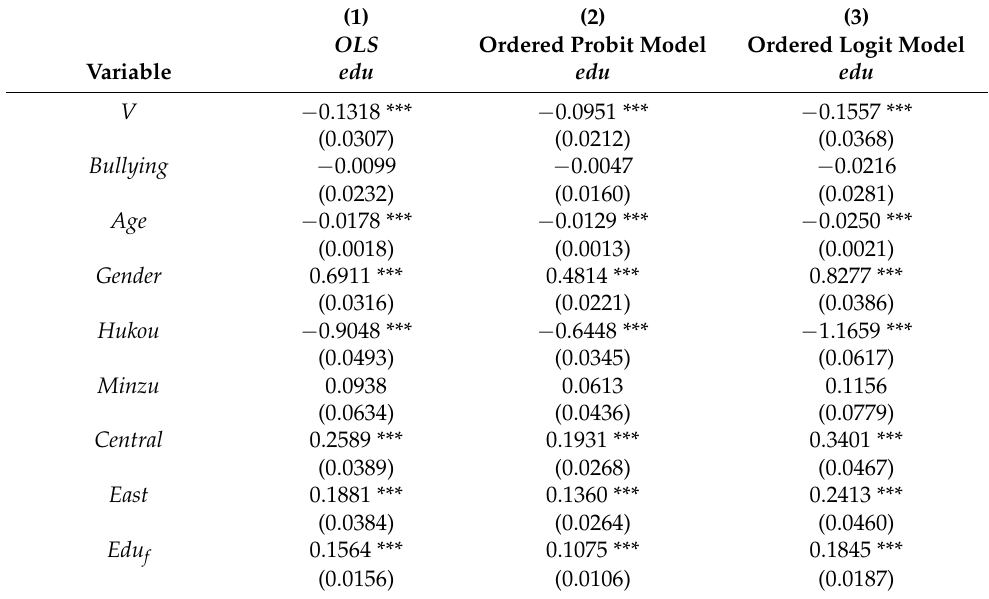
Table 4. Interpreted, explanatory and control